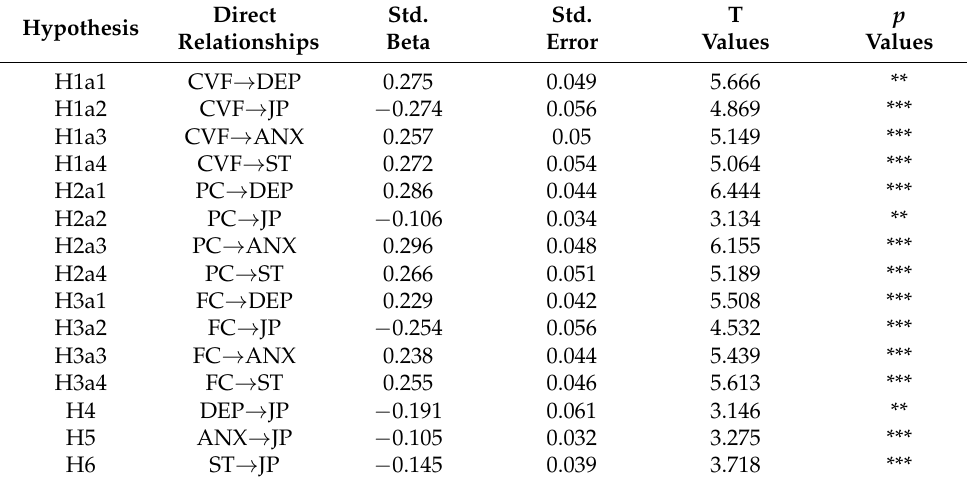
Table 9. Hypotheses testing Direct